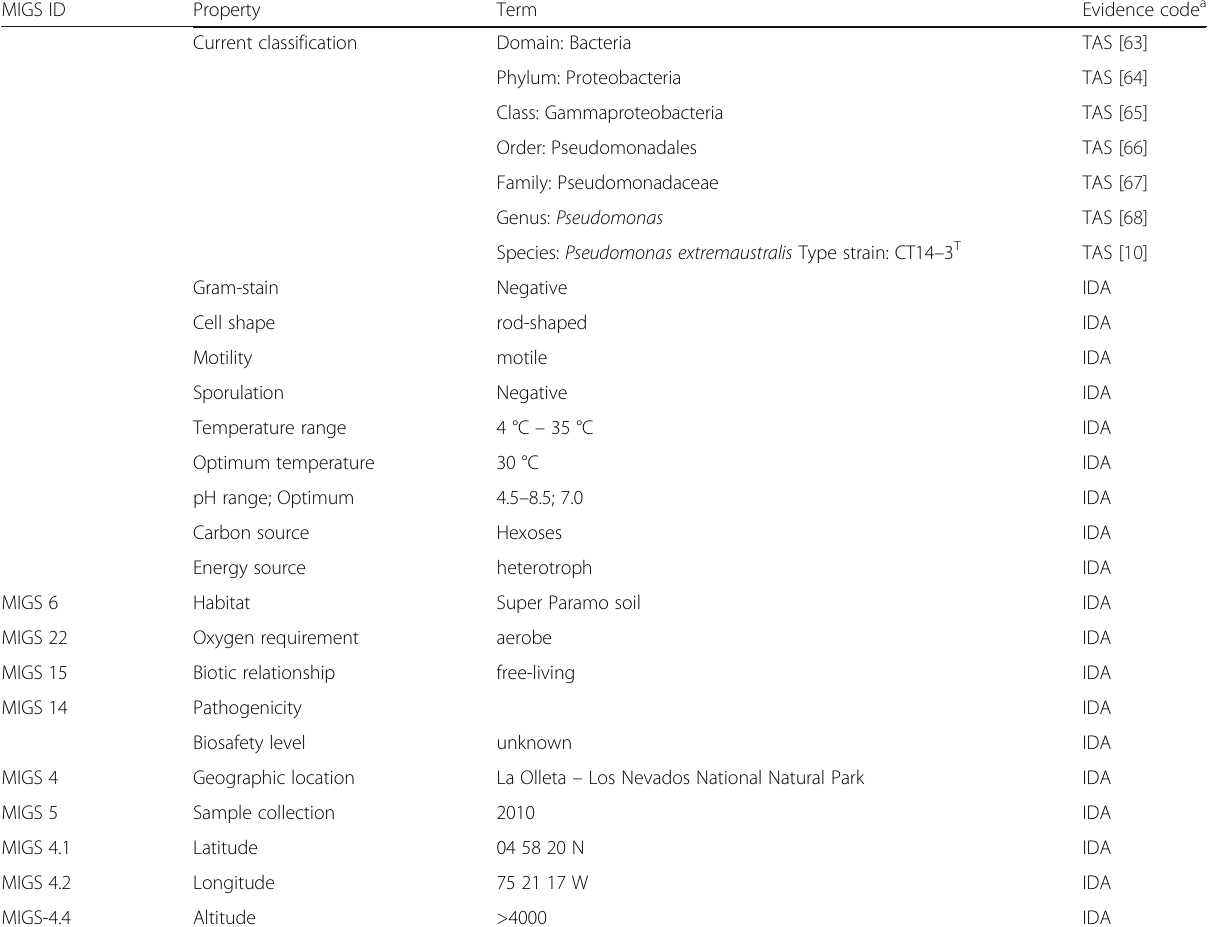
Table 1 Classification and general features of Pseudomonas extremaustralis strain USBA-GBX 505, according to MIGS standards [24] MIGS